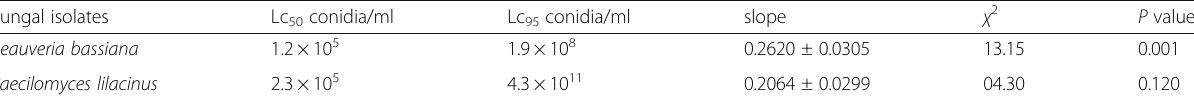
Table 2 Virulence of fungal isolates against second-instar larvae of Galleria mellonella expressed as the LC 50 , LC 95 , and slope of toxicity regression lines after 10 days of dipping in different concentration Fungal isolates Lc 50 conidia/ml